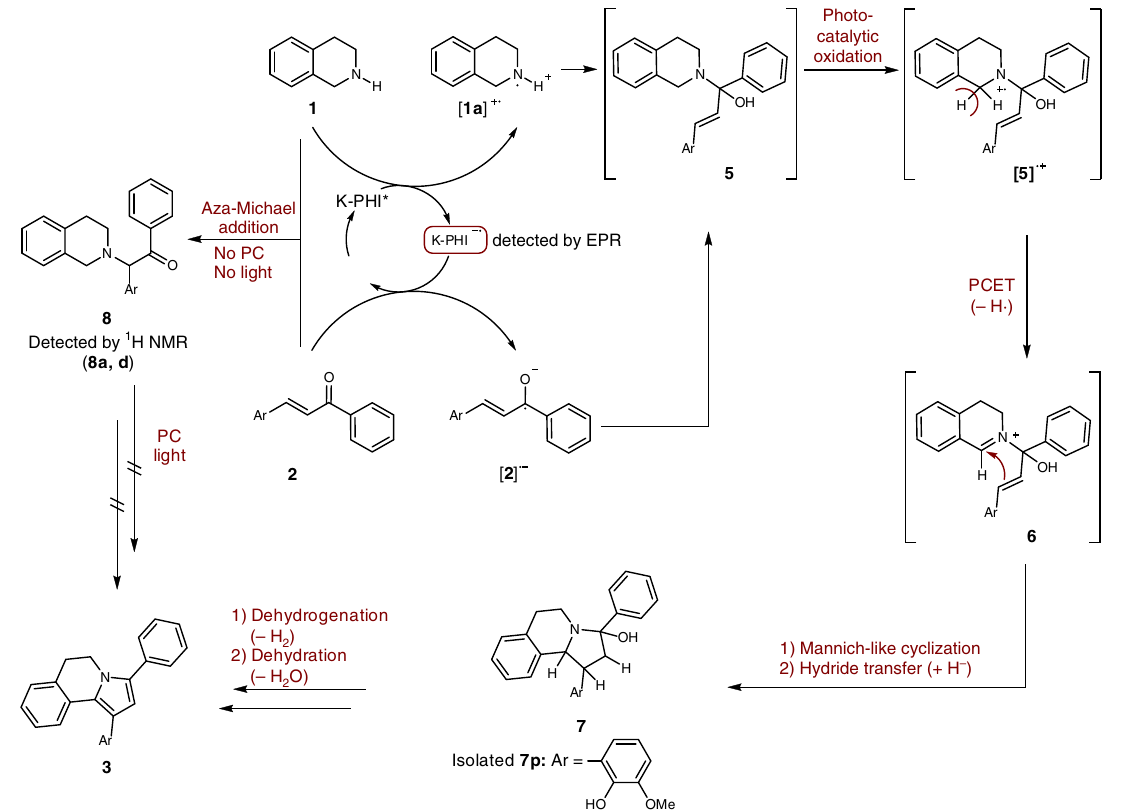
Fig. 9 A proposed sequence of chemical reactions — photocatalytic synthesis of DHPIQ. PC stands for